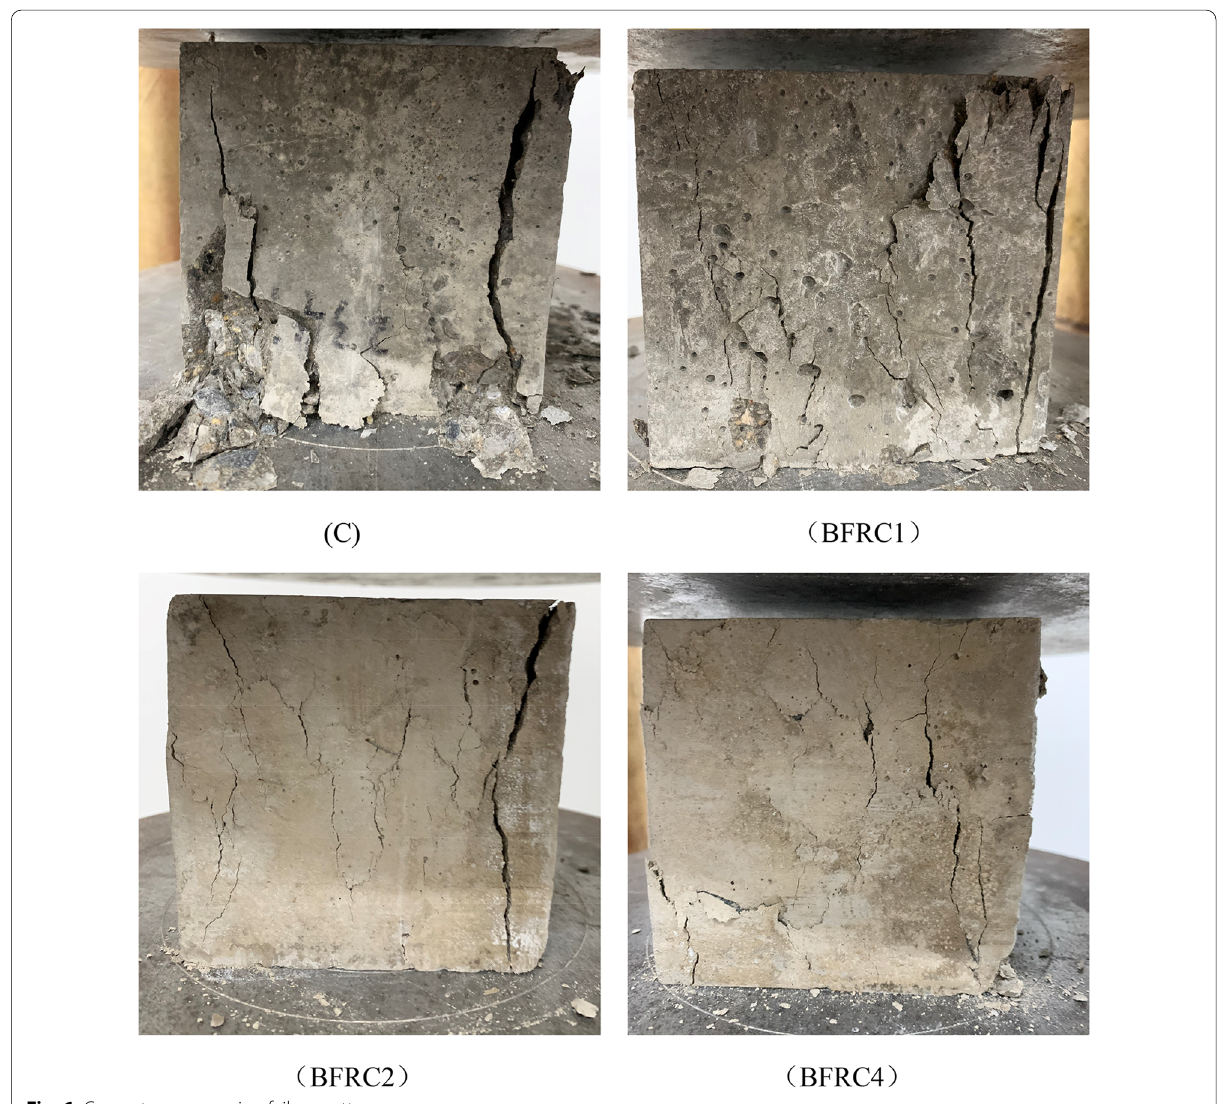
Fig. 6 Concrete compression failure